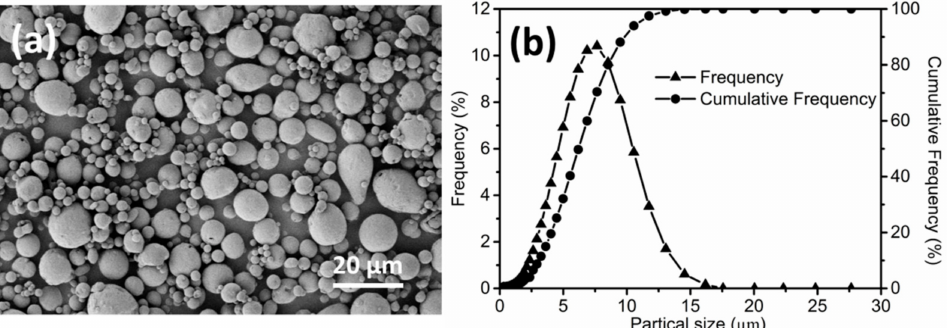
Figure 1. ( a ) Morphology and ( b ) granule size distribution of Al–Si alloy